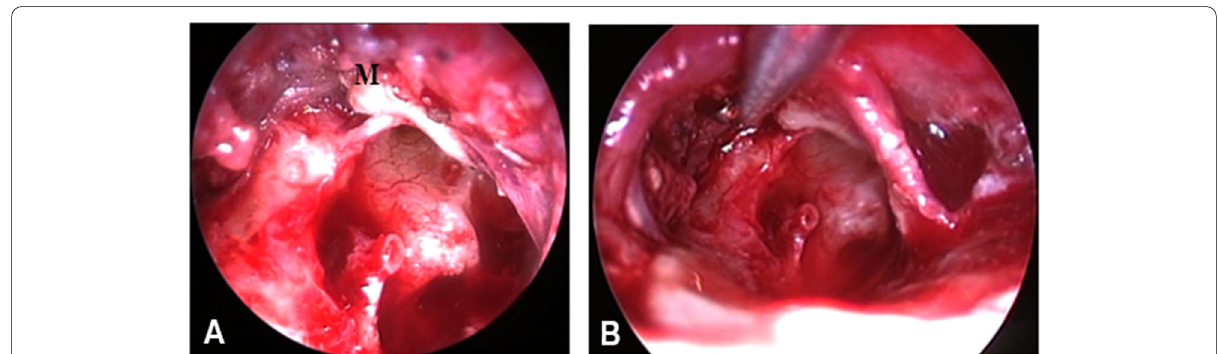
Fig. 7 A Endoscopic view of the right ear after incus removal and nibbling of malleus head showing bone fragment and hematoma compressing the GG, M. refers to the malleus. B Decompression of the GG